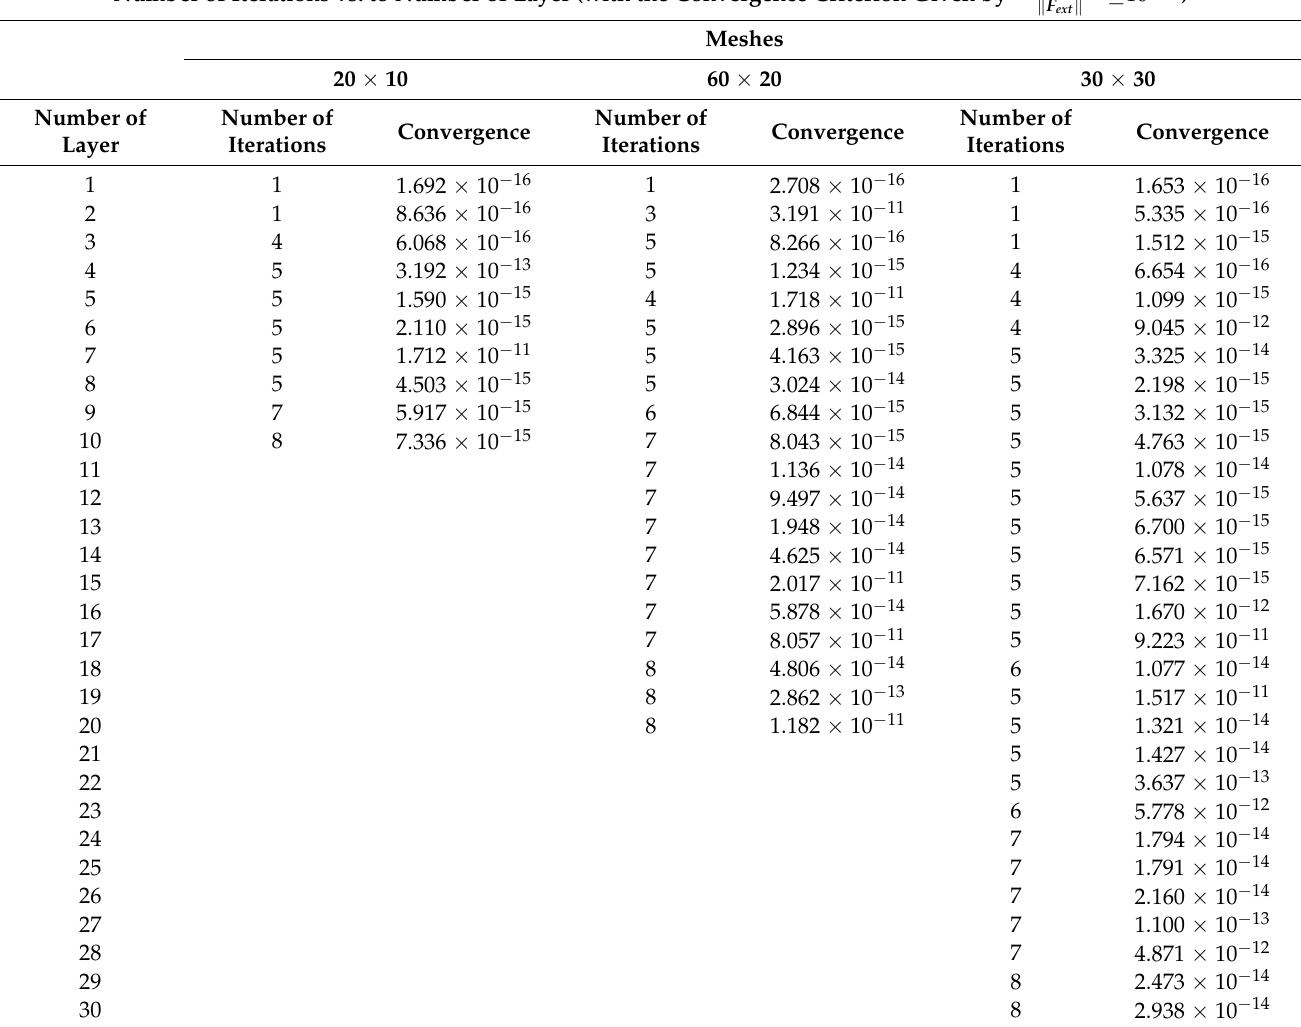
Table 2. Convergence rate and number of iterations by loading: 2D